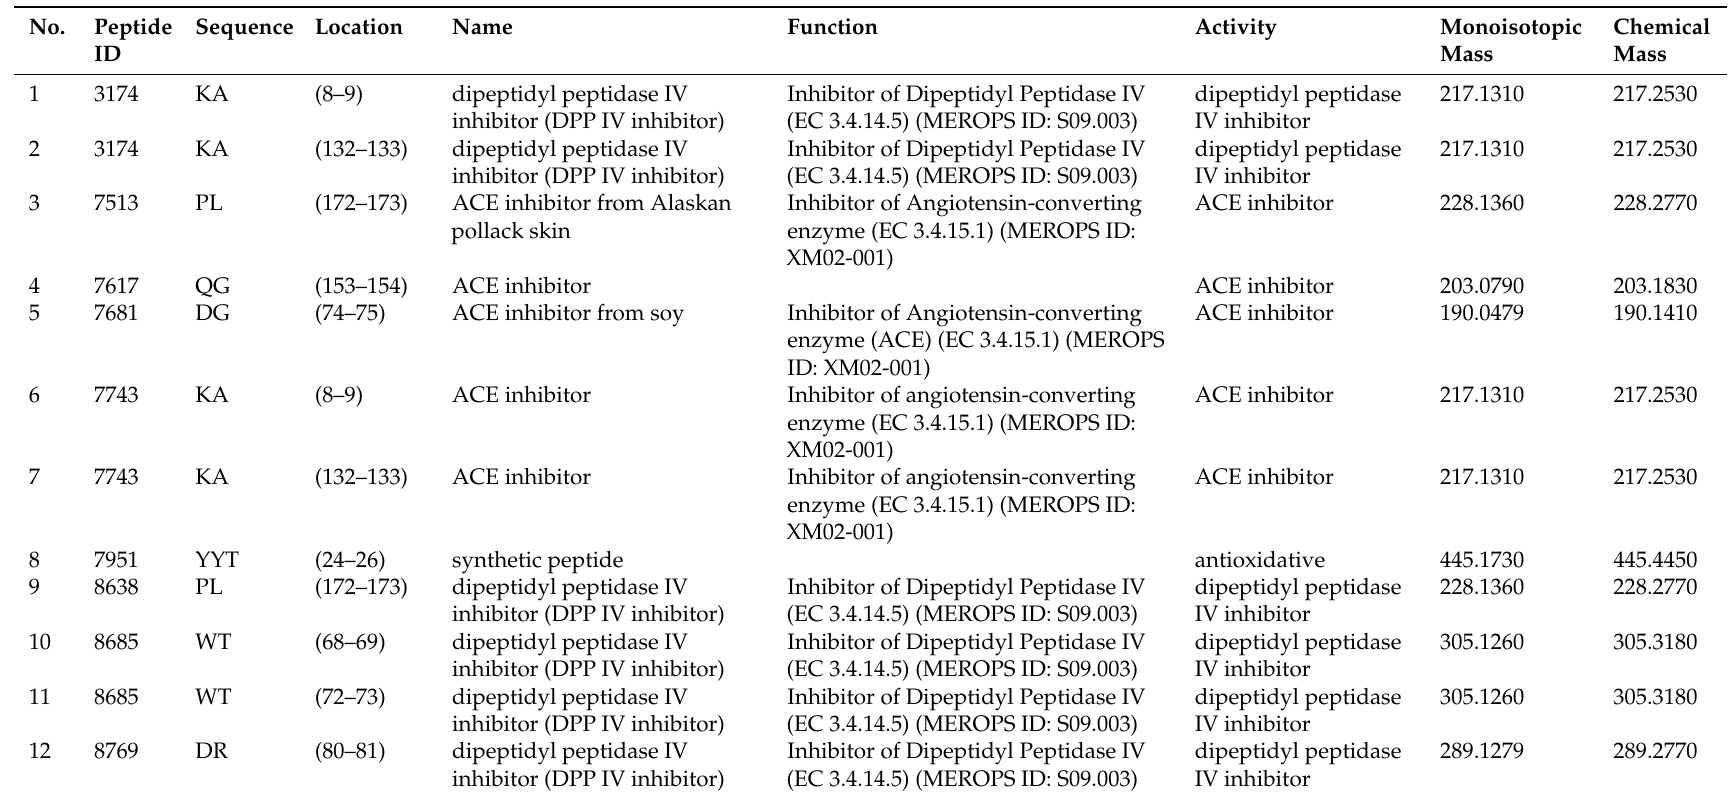
Table A37. Bioactive peptides from RubisCO of Halophila stipulacea . In silico enzymatic cleavage was carried out by using stem